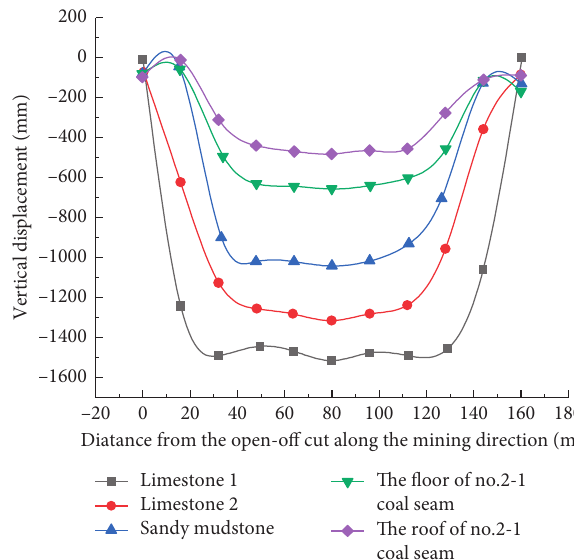
Figure 12: Vertical displacement curve for the overlying strata in the mining of the rock-coal composite protective